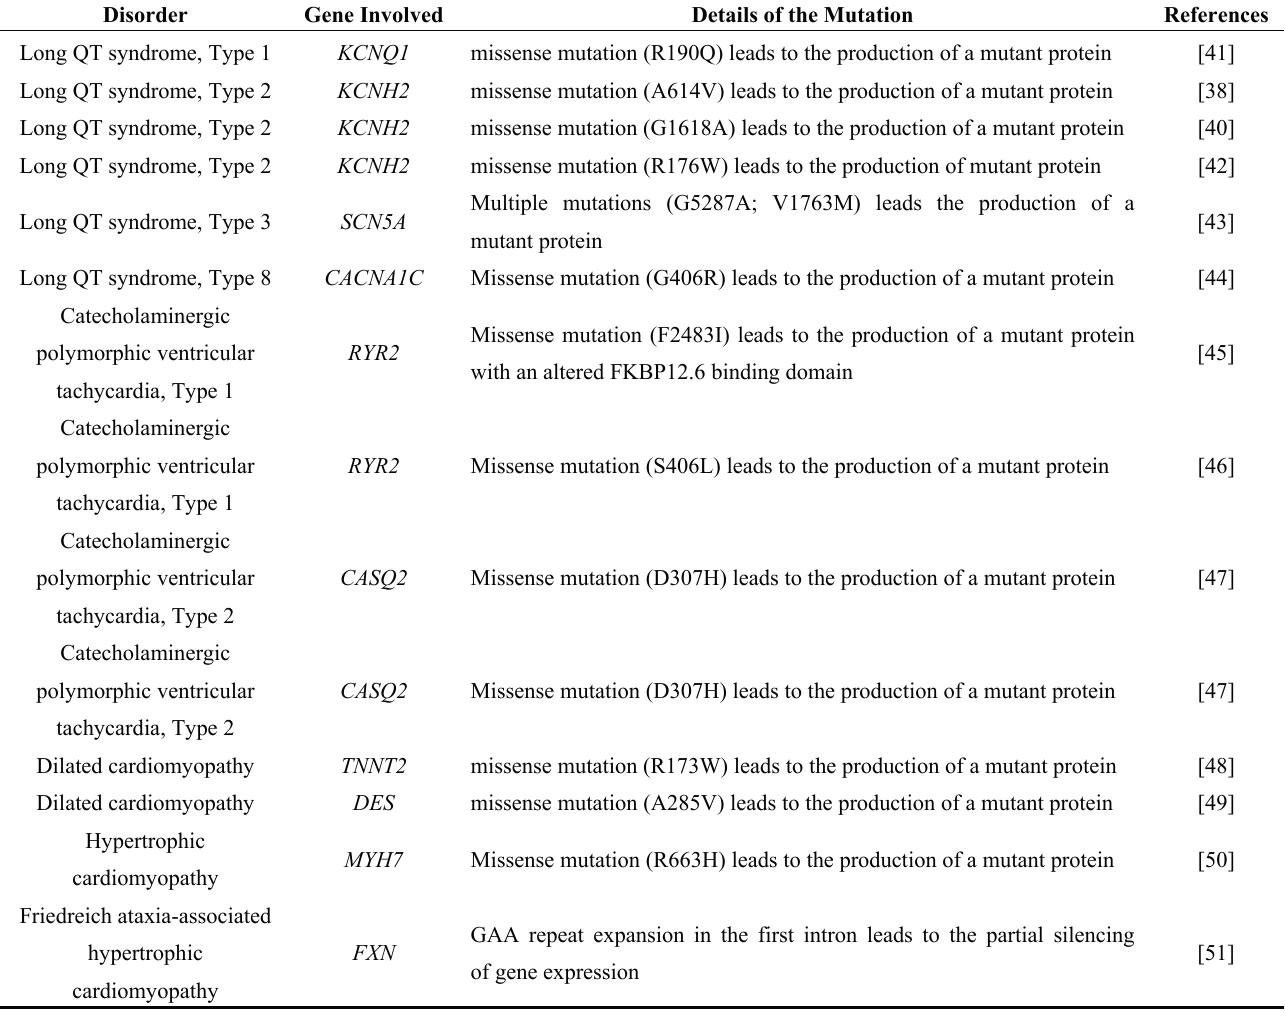
Table 2. Examples of using iPSCs-derived cardiomyocytes for modeling genetic cardiomyopathies.